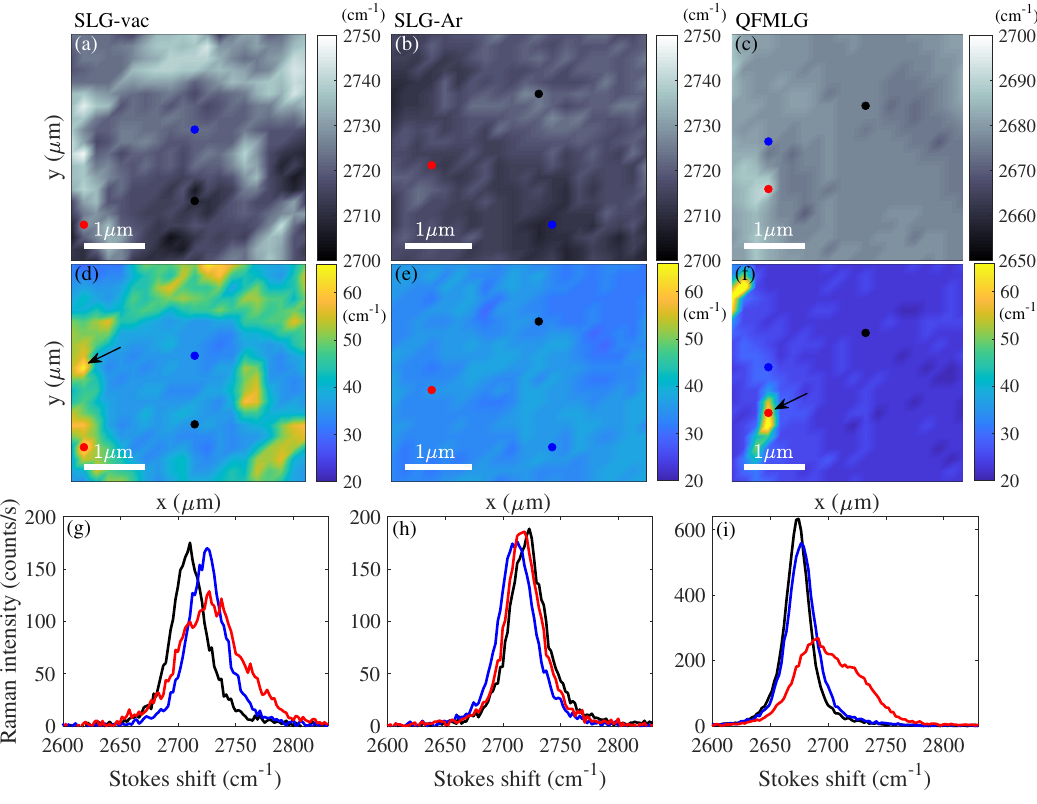
Figure 5. Maps of Raman scattering. The map of ( a – c ) 2D peak position and ( d – f ) 2D peak FWHM measured in ( a , d , g ) SLG-vac, ( b , e , h ) SLG-Ar and ( c , f , i ) QFMLG. We also show 2D peak line shape at three locations marked by black, red and blue circles. The spectra are plotted using corresponding black, red and blue curves in ( g – i